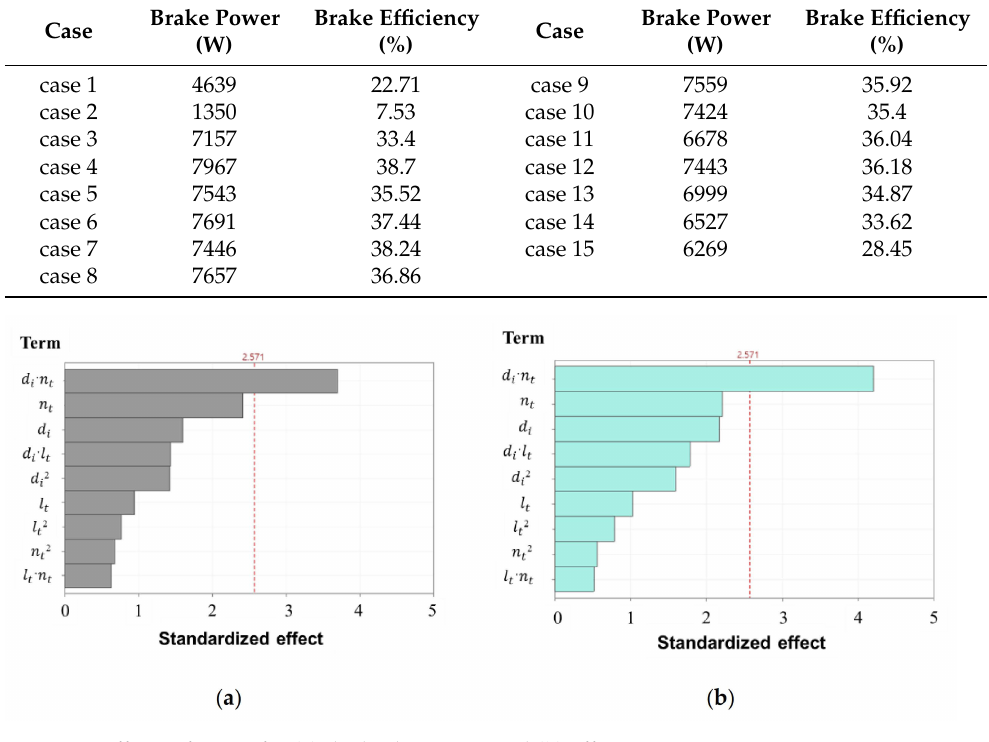
Figure 9. Effects of terms for ( a ) the brake power and ( b )